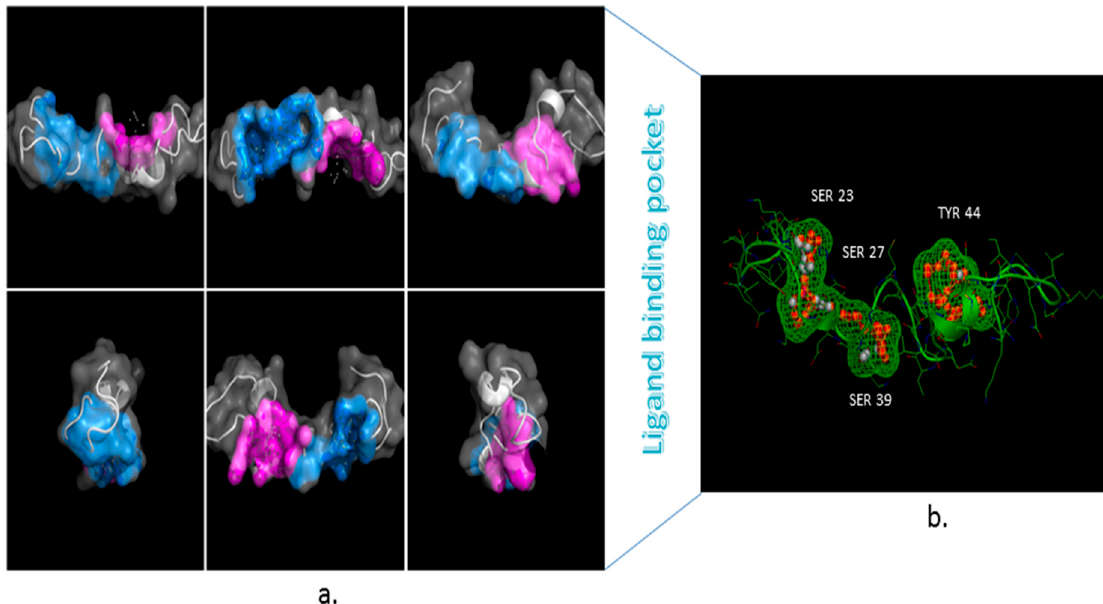
Figure 6. ( a ) Tau Fpocket binding site characteristics, including pocket shape, nature of residues, and interaction profiles on molecular dynamics trajectories protein surface images to detect highly conserved domains; ( b ) Tau protein cavity zoom view of two conserved domains with mesh of Fpocket-predicted Ser and Tyr sites.